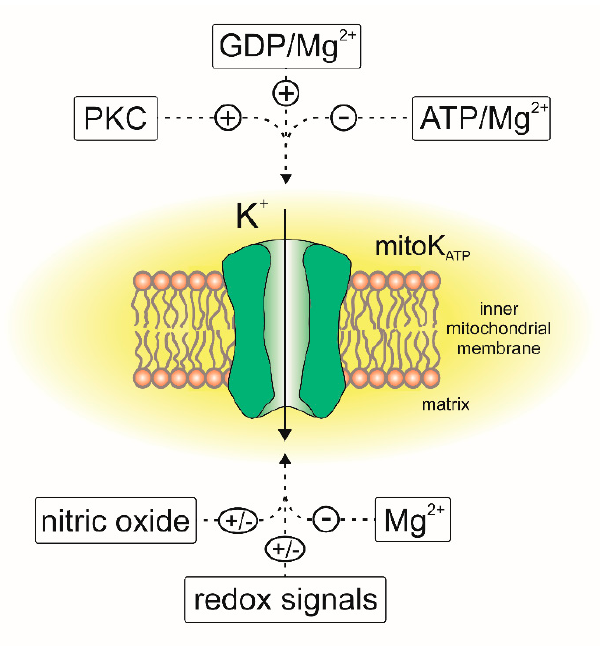
Figure 3. Regulation of the mitoK ATP channels by endogenous factors. “+,” activation of the channel; “–,” inhibition of the channel activity.